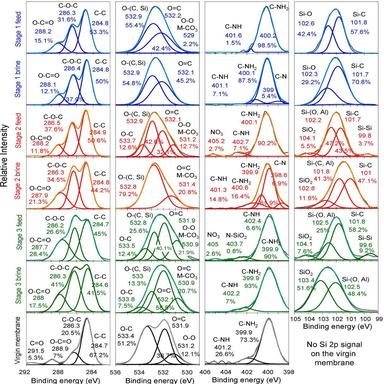
XPS high-resolution spectra for the fouled and virgin membranes. C 1s, O 1s, N 1s, and Si 2p are depicted in columns 1, 2, 3, and 4 respectively. Spectra for the feed and brine membrane coupons from Stage 1 (rows 1 and 2 in blue), Stage 2 (rows 3 and 4 in red), and Stage 3 (rows 5 and 6 in green). The bottom row in black is the negative control of the virgin ESPA2 membrane. (For interpretation of the references to color in this figure legend, the reader is referred to the Web version of this article.)